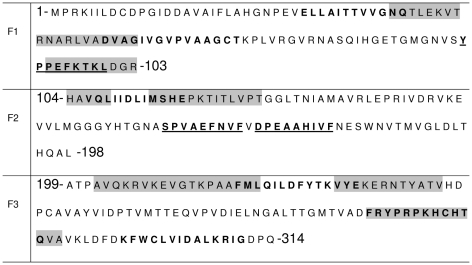
Nucleoside hydrolase NH36 T cell and antibody epitope mapping.The peptide sequence of MHC class II-IAd and IEd, haplotype H2d CD4+ T cell epitopes (bold), of MHC class I Ld-CD8+ T cell predicted epitopes (underlined) and of epitopes for antibodies (grey background) in the F1, F2 and F3 fragments of the NH36 Nucleoside hydrolase of Leishmania donovani.